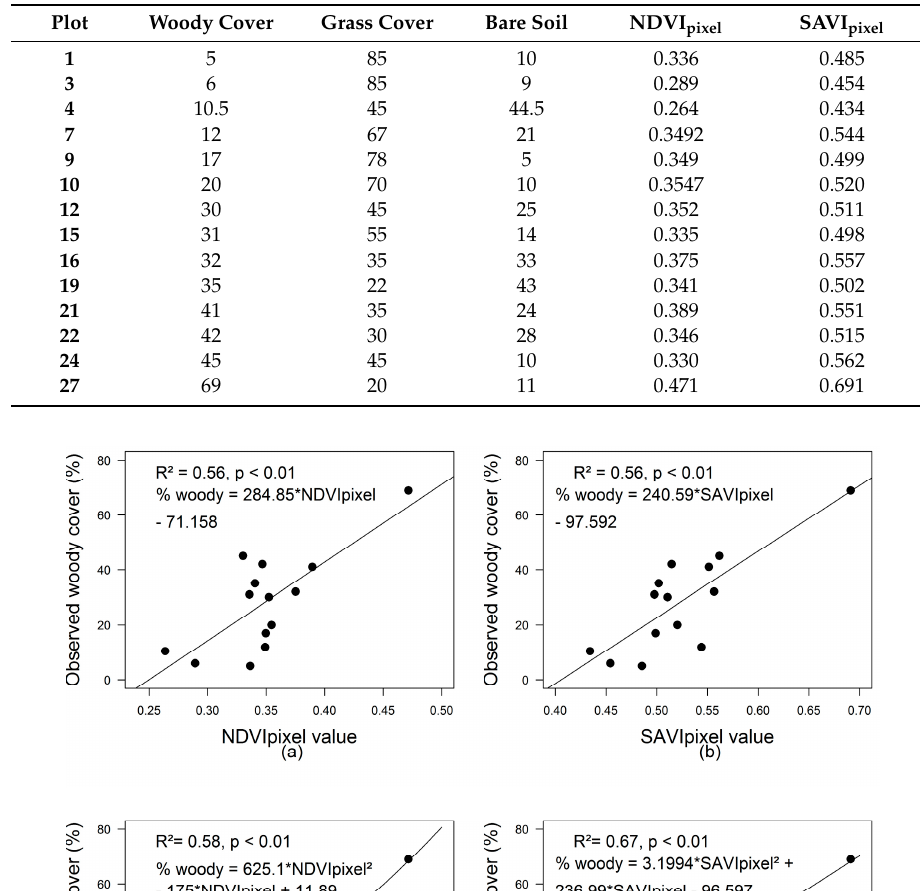
Table 1. Woody, grass, bare soil, NDVI pixel and SAVI pixel for woody cover estimation.